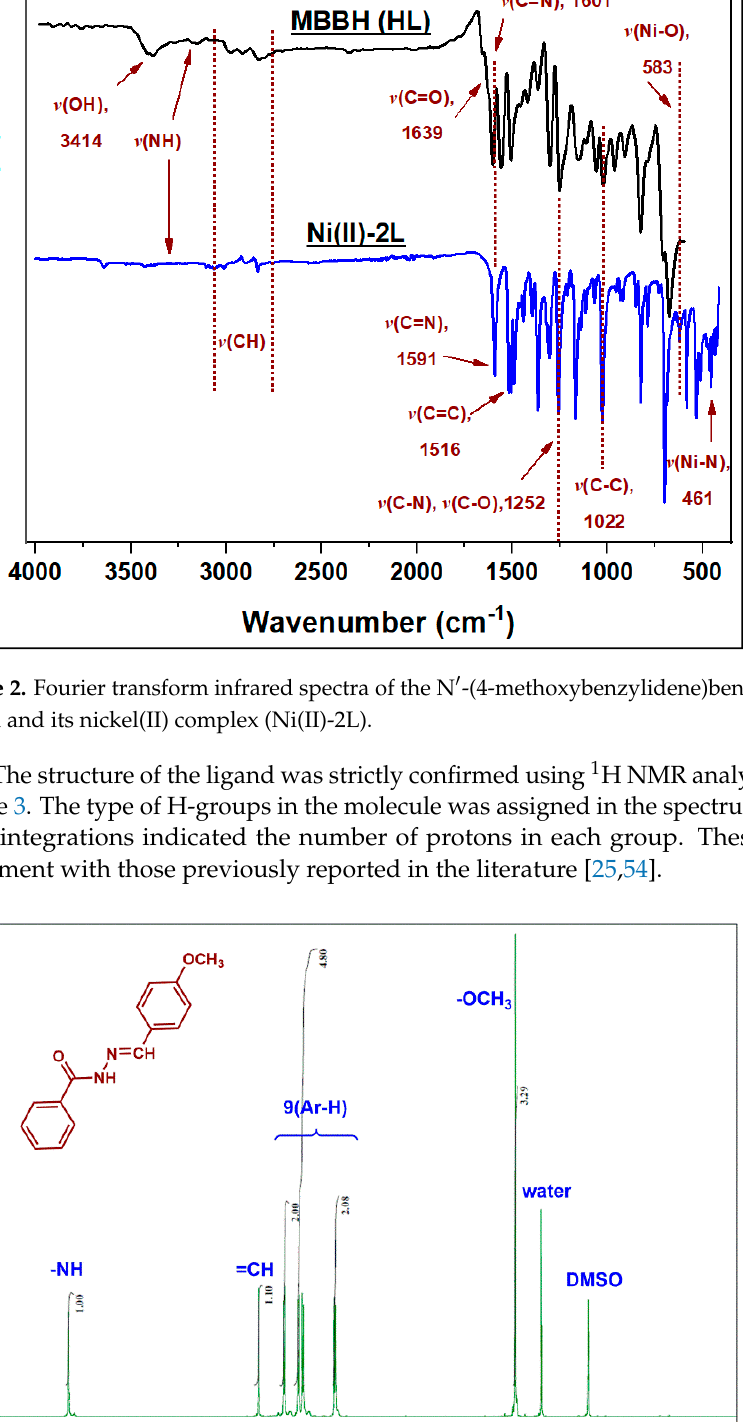
Figure 3. 1 H NMR spectrum of N ′ -(4-methoxybenzylidene) benzohydrazide (HL) in CDCl 3 .